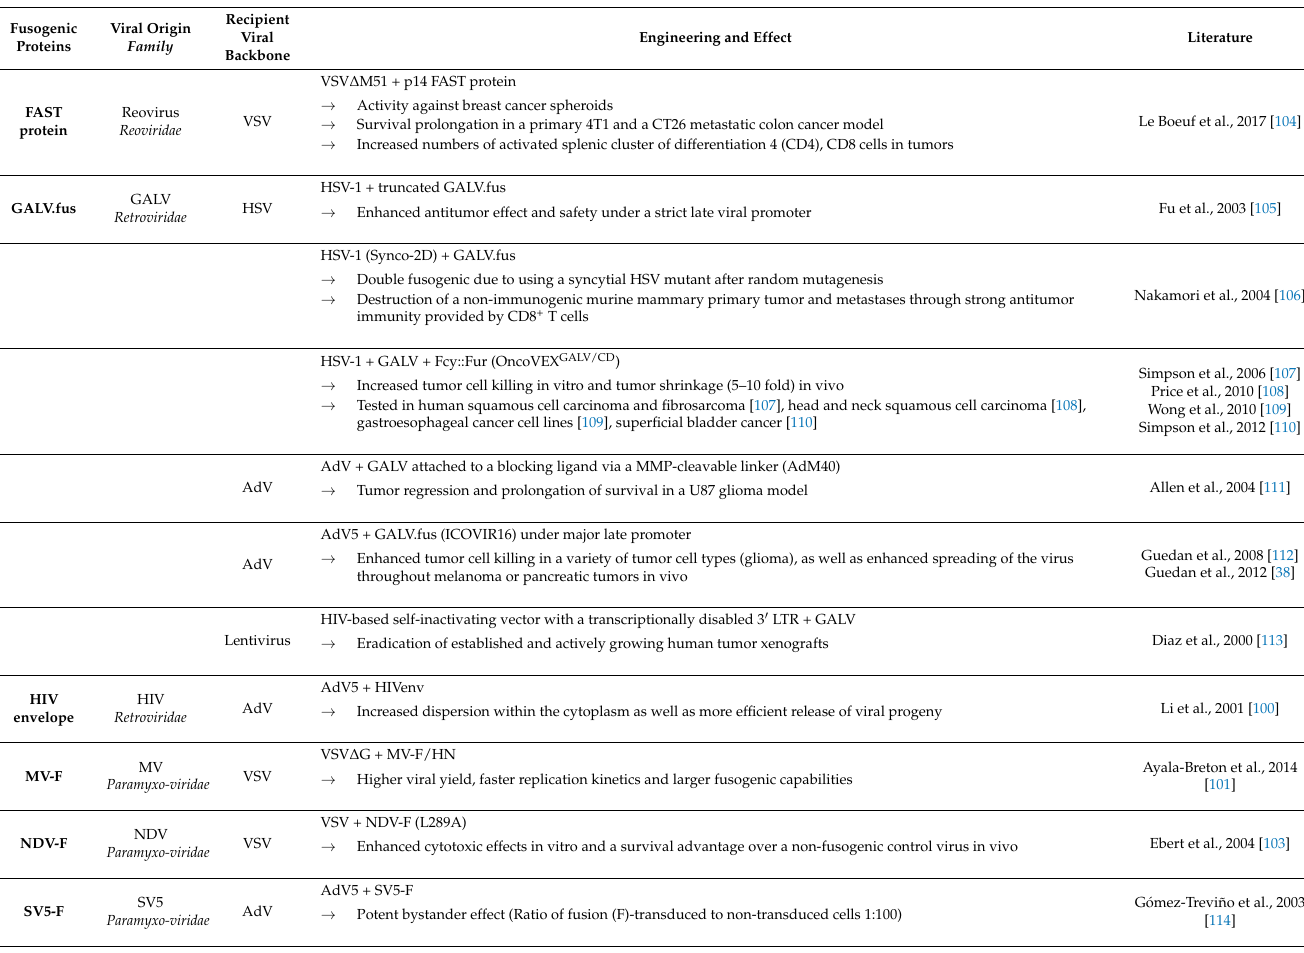
FAST: Fusion-Associated Small Trans-membrane; VSV: Vesicular Stomatitis Virus; GALV: Gibbon Ape Leukemia Virus; HSV: Herpes Simplex Virus; AdV: Adenovirus; AdV: Adenovirus; HIV: Human Immunodeficiency Virus; MV: Measles Virus; NDV: Newcastle Disease Virus; SV: Simian Parainfluenza Virus; MMP: matrix metalloproteinase; LTR: long terminal